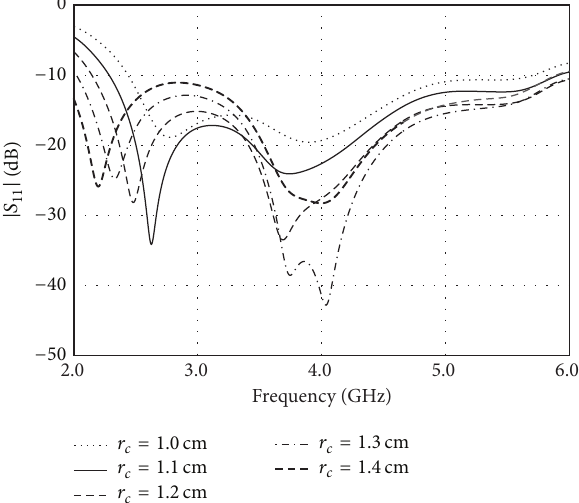
and maximum gains are 3.4 and 9.3 dBi for the simulation and 3.7 and 8.7 dBi for the prototype antenna.